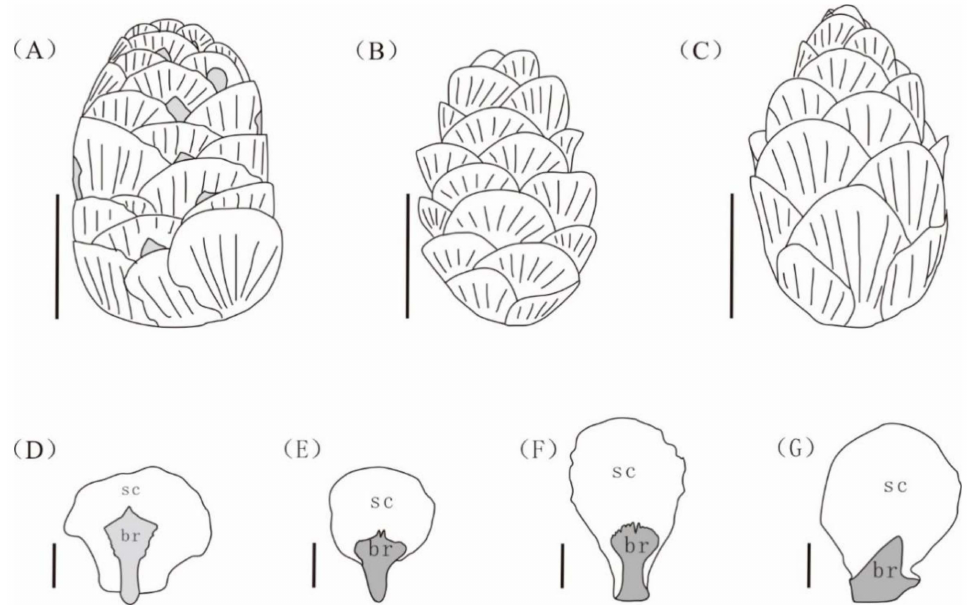
Figure 4. The line drawing of seed cones and bract-scale complexes of Nothotsuga mulaensis and extant Tsuga . br = bract, sc = scale. ( A ) Seed cone of N. mulaensis . ( B ) Seed cone of T. chinensis . ( C ) Seed cone of T. dumosa. ( D ) Scale-bract complexes of N. mulaensis . ( E ) Scale-bract complexes of T. chinensis . ( F , G ) Scale-bract complexes of T. dumosa . ( A – C ) Scale bar = 10 mm; ( D – G ) Scale bar = 5